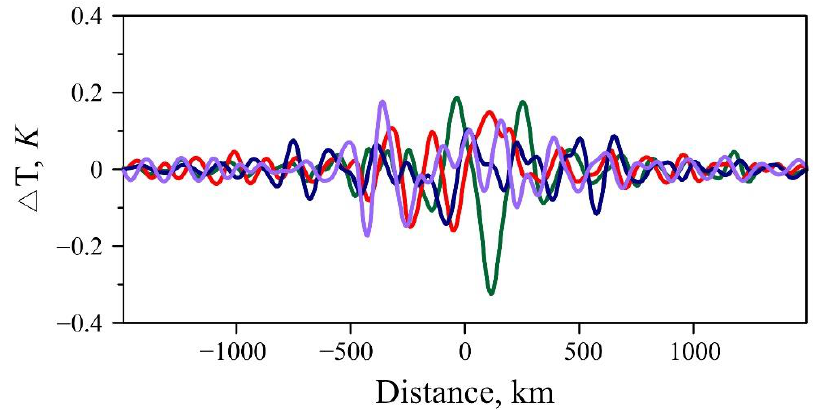
Figure 8. Temperature variations along the horizontal axis at an altitude of 250 km for 1.8 h (green line), 2.2 h (red line), 2.5 h (blue line), 2.7 h (purple line).